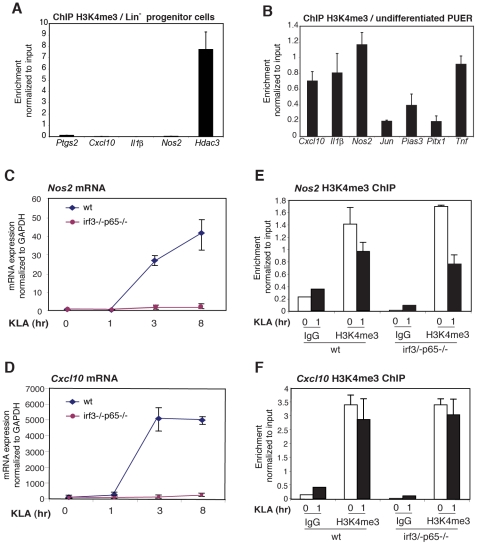
The H3K4me3 mark can be established independently of signal-dependent activators.A. The H3K4me3 mark is absent from the Ptgs2, Cxcl10, IL1b and Nos2 promoters in Lin- hematopoietic progenitor cells. B. The H3K4me3 mark is present on the Ptgs2, Cxcl10, IL1b and Nos2 promoters in PUER myeloid progenitor cells. C, D., KLA induction of Nos2 and Cxcl10 in MEFs requires p65 and IRF3. WT or p65/IRF3 DKO MEFs were treated for the indicated times with KLA and Nos2 (C) and Cxcl10 (F) mRNA levels were determined by Q-PCR. E, F., Q-PCR analysis of H3K4me3 at the Nos2 and Cxcl10 promoters under basal and KLA-treated conditions in WT and p65/IRF3 DKO MEFS.